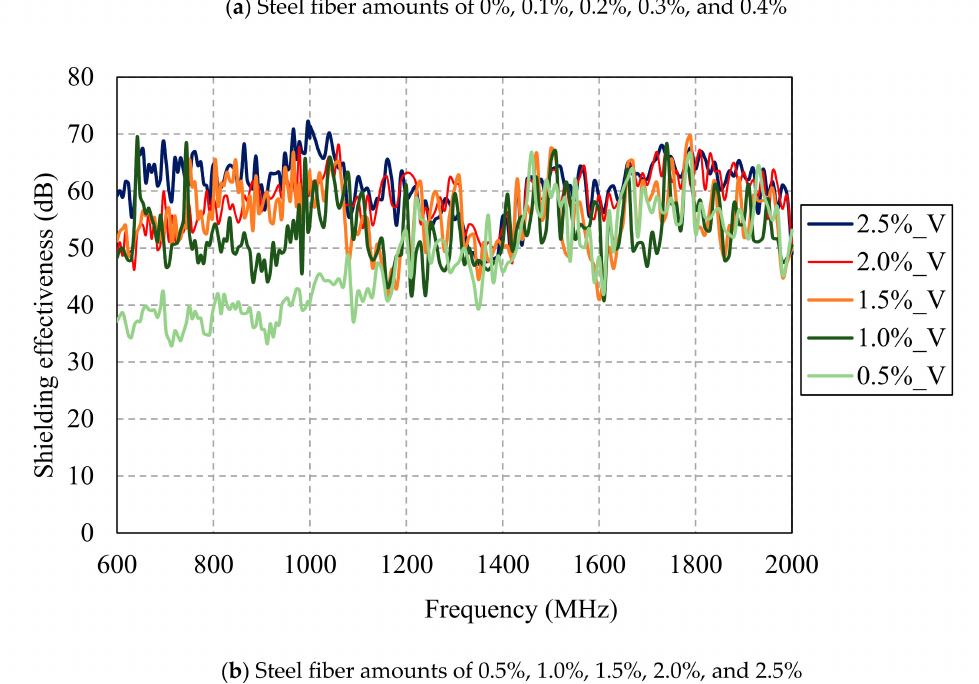
Figure 14. SE results of HPFRCC for di ff erent amount of steel fibers measured with a vertical